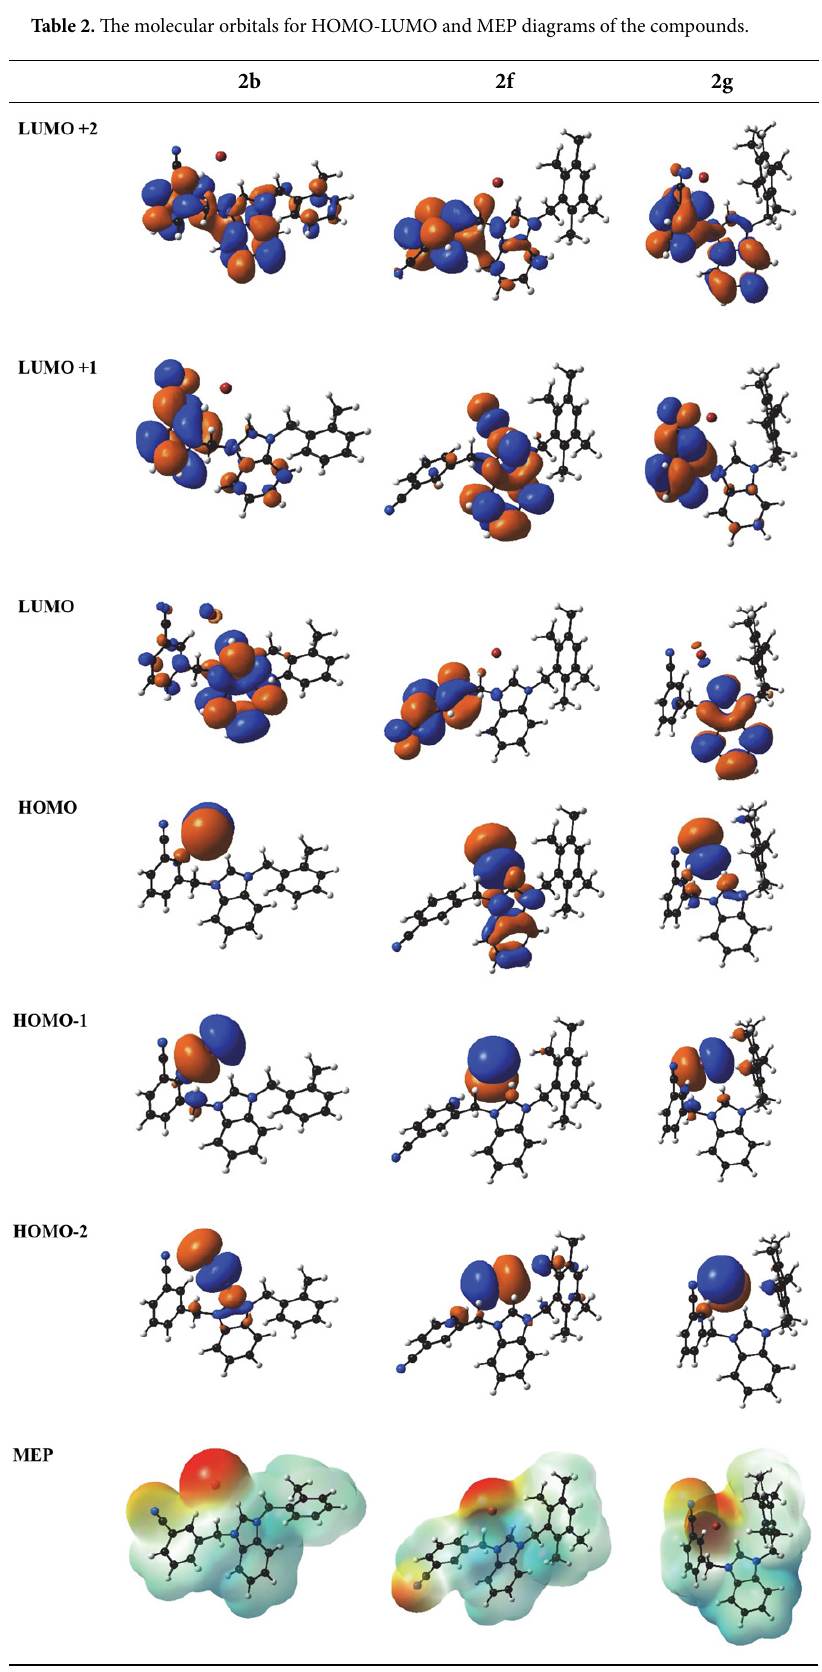
Table 2. The molecular orbitals for HOMO-LUMO and MEP diagrams of the